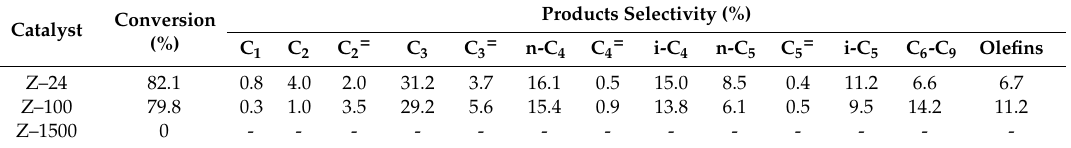
Figure 2. The conversion of the catalytic cracking of n-decane and the products distribution over ( a ) Z–24 and ( b ) Z–100. The reaction conditions: Catalyst weight = 0.3 g, F C10 = 0.03 g/min, F gas = 20 mL/min, Reaction temperature = 400 °C, Pressure = 0.1 MPa. Table 1. The conversion of the catalytic cracking of n-decane and the products distribution a .